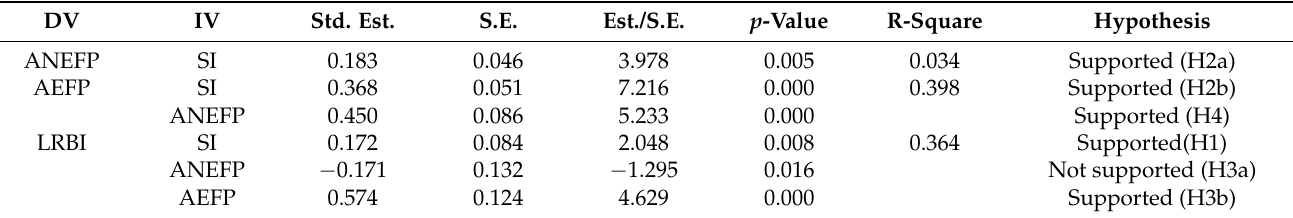
Table 5. Results of the hypothesis